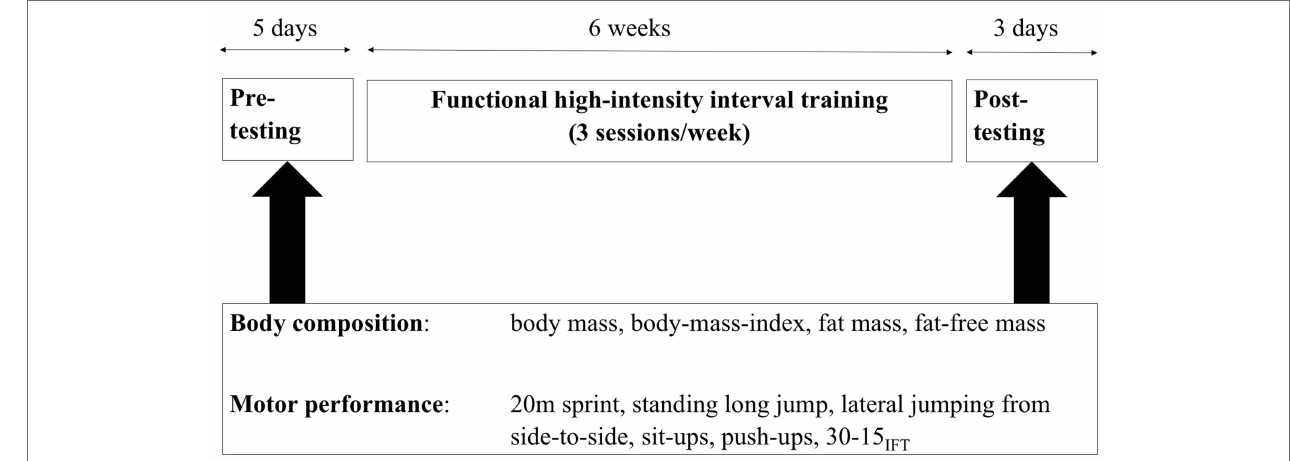
FIGURE 1 | The timeline and outcome variables of this